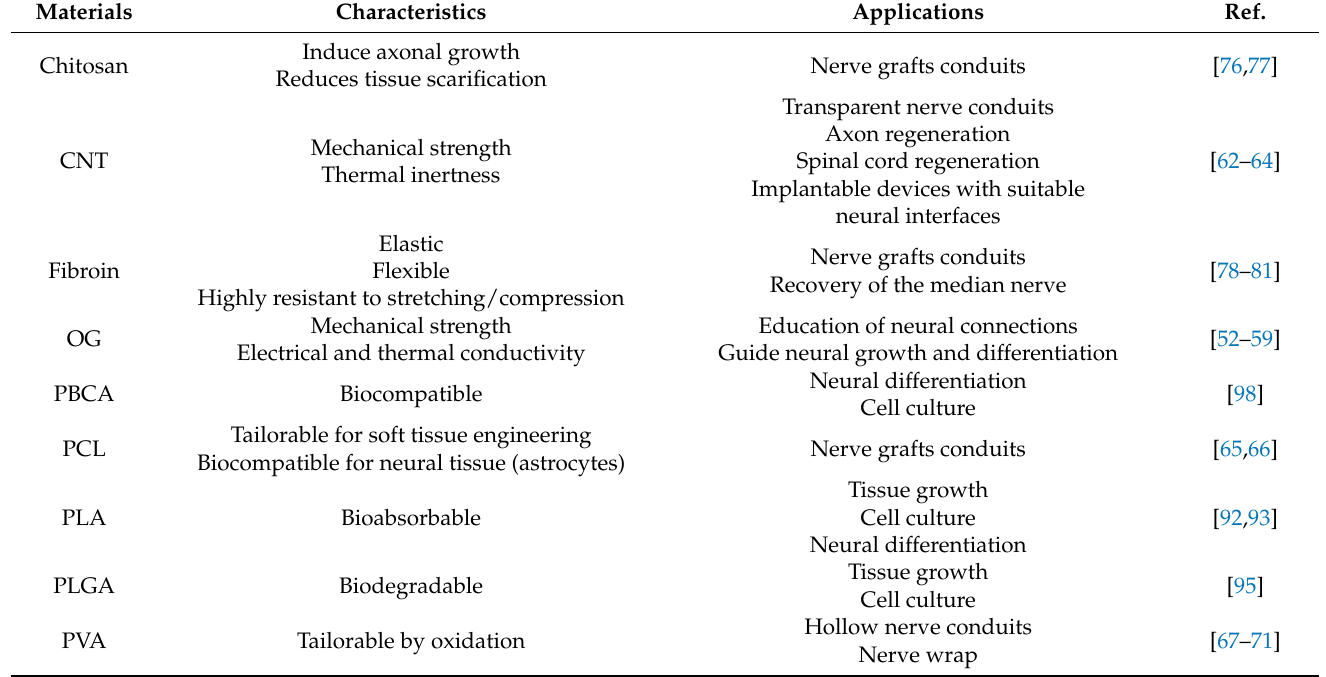
Table 2. Characteristics and applications of biomaterials in the neurological